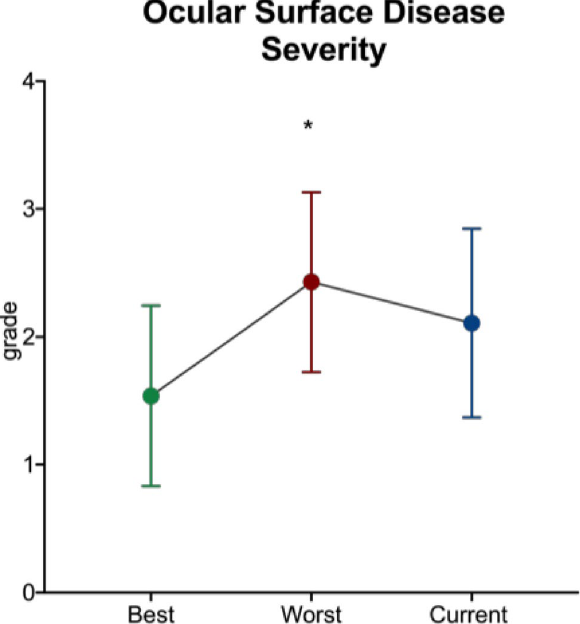
Figure 2. Ocular surface disease severity score based collectively on patients’ parameters at their worst, best, and current eye